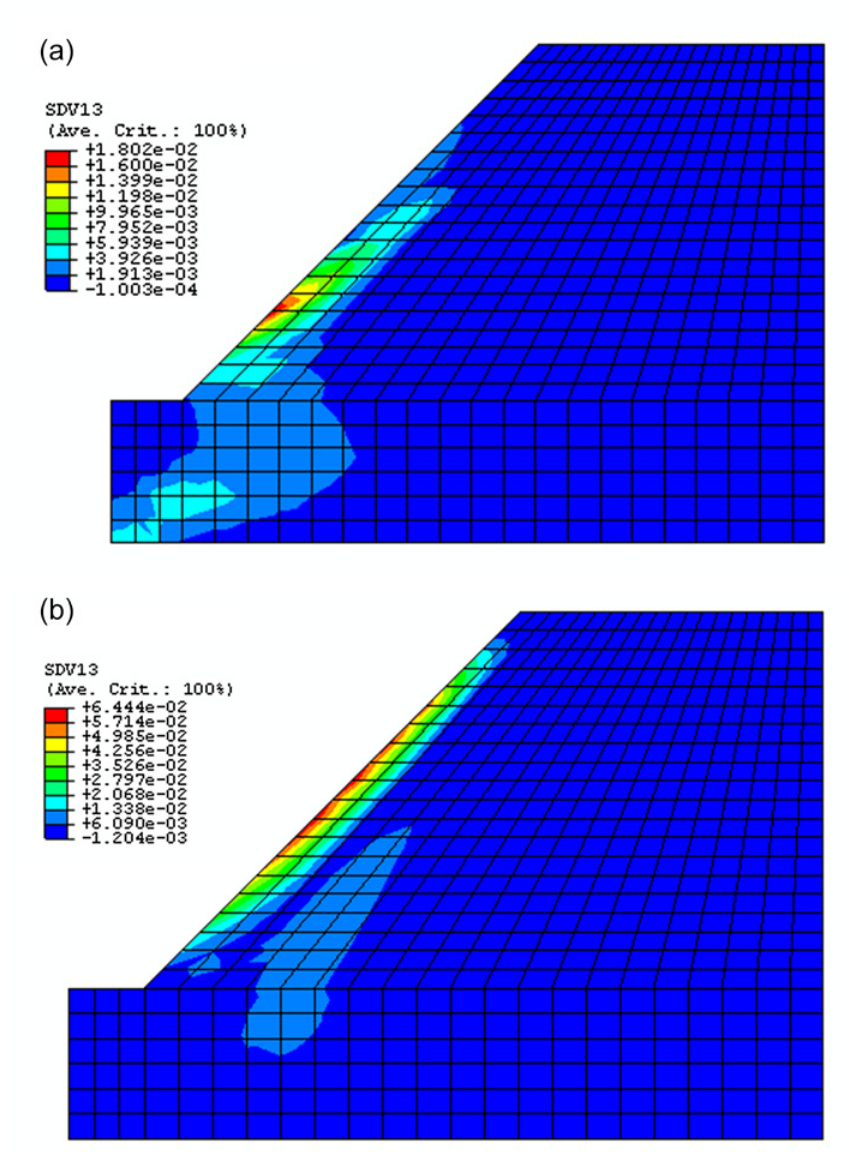
Fig 23. The contour for equivalent plastic deviator strain calculated by proposed constitutive model for the different slopes((a) The contour for equivalent plastic deviator strain calculated by proposed constitutive model for the first slope; (b) The contour for equivalent plastic deviator strain calculated by proposed constitutive model for the second slope)